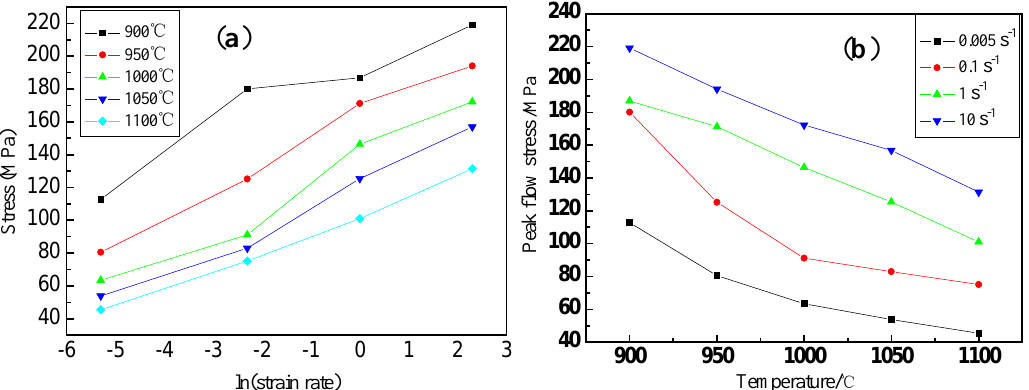
Figure 2. Relation between peak flow stress with ( a ) ln (strain rate) and ( b ) deformation temperatures.